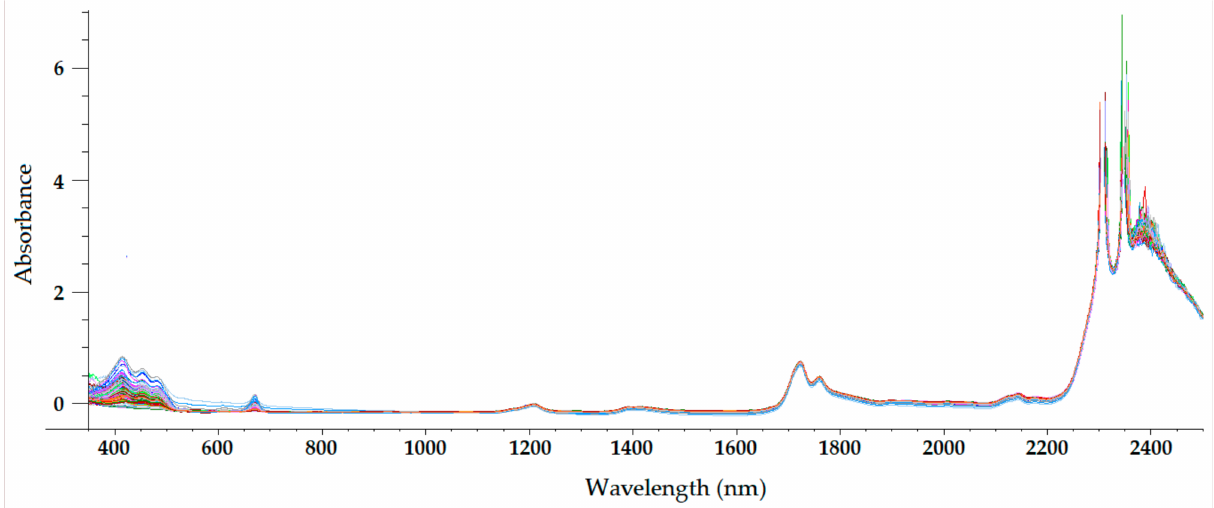
Figure 4. Mean-normalized visible/NIR spectra of 127 olive oils obtained with 2-mm path-length quartz cuvette